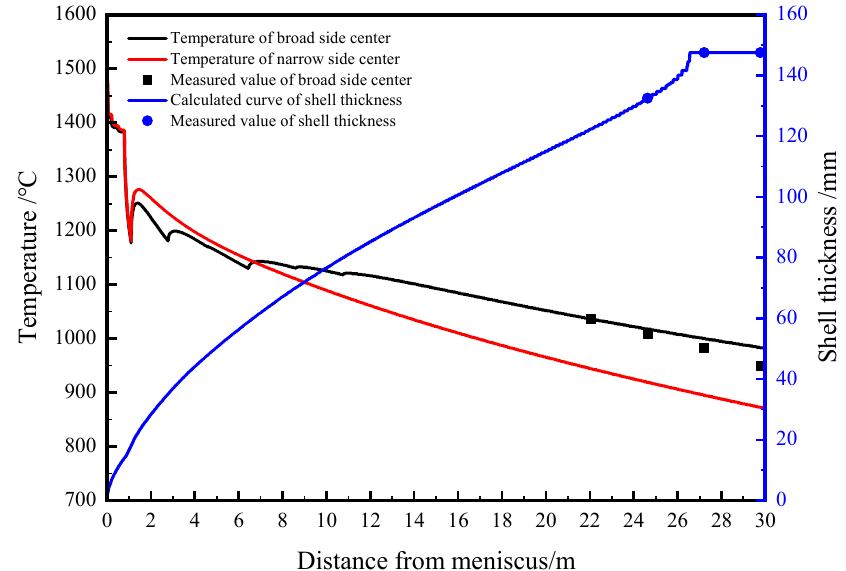
Figure 5. Comparison of the calculated temperature of the slab narrow side center and of the shell thickness with measured values.